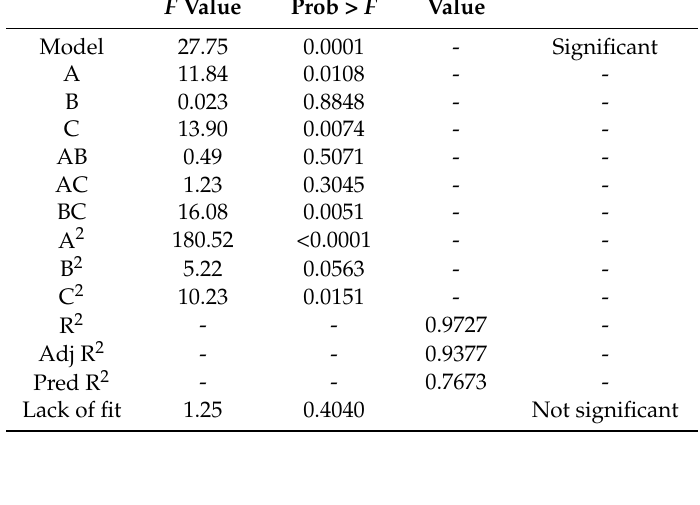
Table 4. ANOVA of response surface methodology (RSM) variables for specific activity of immobilized SrtA.